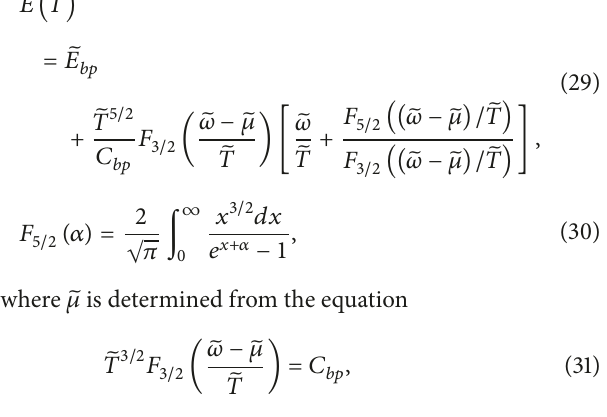
Relation of ̃𝜇 with the chemical potential of the system 𝜇 is given by the formula ̃𝜇 = (𝜇 − 𝐸 𝑏𝑝 )/𝜔 ∗ . From (29)-(31) expressions for the free energy Δ𝐹 = −(2/3)Δ𝐸, Δ𝐹 = 𝐹 − 𝑁, Δ𝐸 = 𝐸 − 𝐸 𝑁 and entropy 𝑆 = −𝜕𝐹/𝜕𝑇 also follow. 𝐸 𝑏𝑝 𝑏𝑝 ̃𝐸 − Figure 4 illustrates temperature dependencies Δ𝐸 = ̃𝐸 𝜔 𝑏𝑝 for the above-indicated parameter values 𝑖 . Break points (̃𝑇) correspond to the values of critical on the curves Δ𝐸 𝑖 temperatures 𝑇 𝑐 𝑖